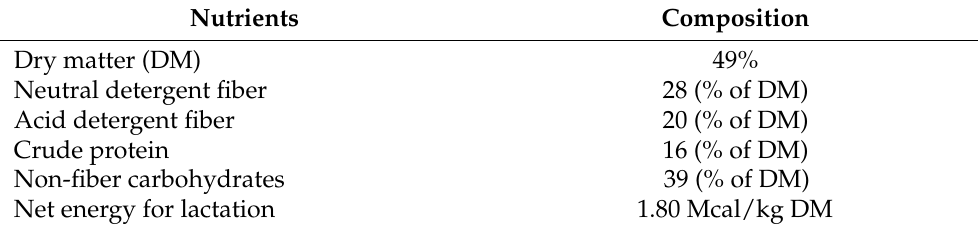
Table 1. Chemical composition of feed